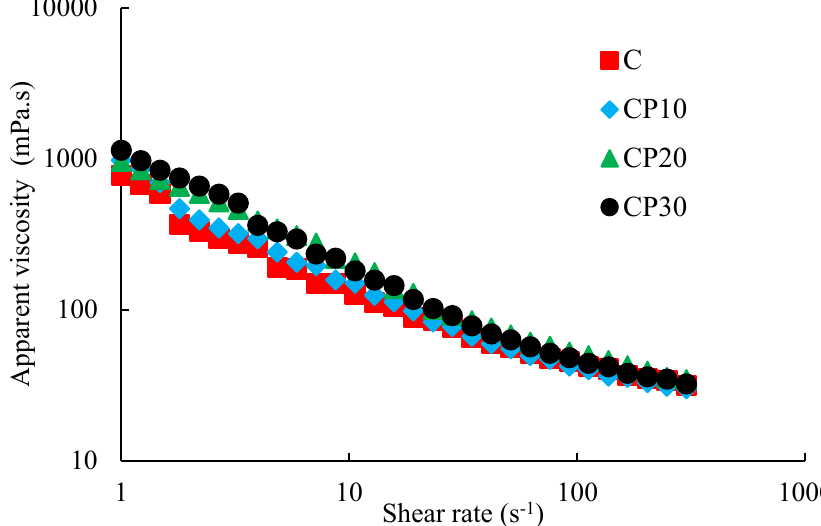
Figure 4. Changes in the apparent viscosity of different BSG dispersions (0.3%) at 20 ◦ C as a function of shear rate; C, CP 10 , CP 20 , and CP 30 indicate unmodified samples and those treated by CP for 10, 20, and 30 min, respectively. Table 2 represents the constant parameters of applied rheological models. Considering the values of the determination coefficient (R 2 ), the rheological data of both native and CP-treated BSG dispersions were best fitted with the Casson model. The shear-thinning characteristic was confirmed by the values of the flow behavior index (n < 1) of the Power Law model. The increase in n values after CP treatment indicated a decrease in the pseudoplasticity of gum dispersions. A higher interaction between BSG chains after modification relatively enhanced the yield stress ( τ 0 ). Naji-Tabasi and Razavi [39] reported n, k, and τ 0 values in the range of 0.36–0.48, 1.83–11.02 Pa.s n , and 0.8–3.85 Pa for different fractions of 1% BSG dispersion at 20 ◦ C, respectively. Hosseini-Parvar, Matia-Merino, Goh, Razavi, and Mortazavi [34] reported dynamic τ 0 values of 3.47 and 11.94 Pa for 1% and 2% BSG dispersions at 20 ◦ C,